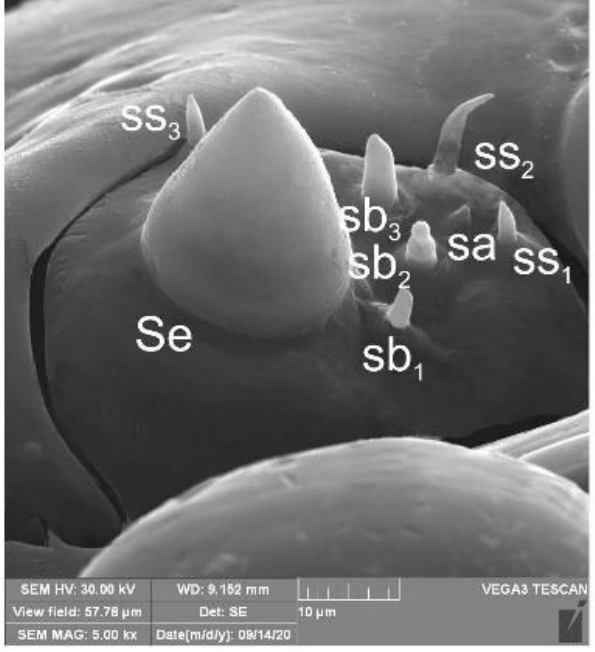
Figure 7. Euryommatus mariae mature larva, antenna (SEM micrograph) (sa—sensillum ampul- laceum, Se—sensorium, ss—sensillum styloconicum, sb—sensillum basiconicum). Se—sensorium, ss—sensillum styloconicum, sb—sensillum